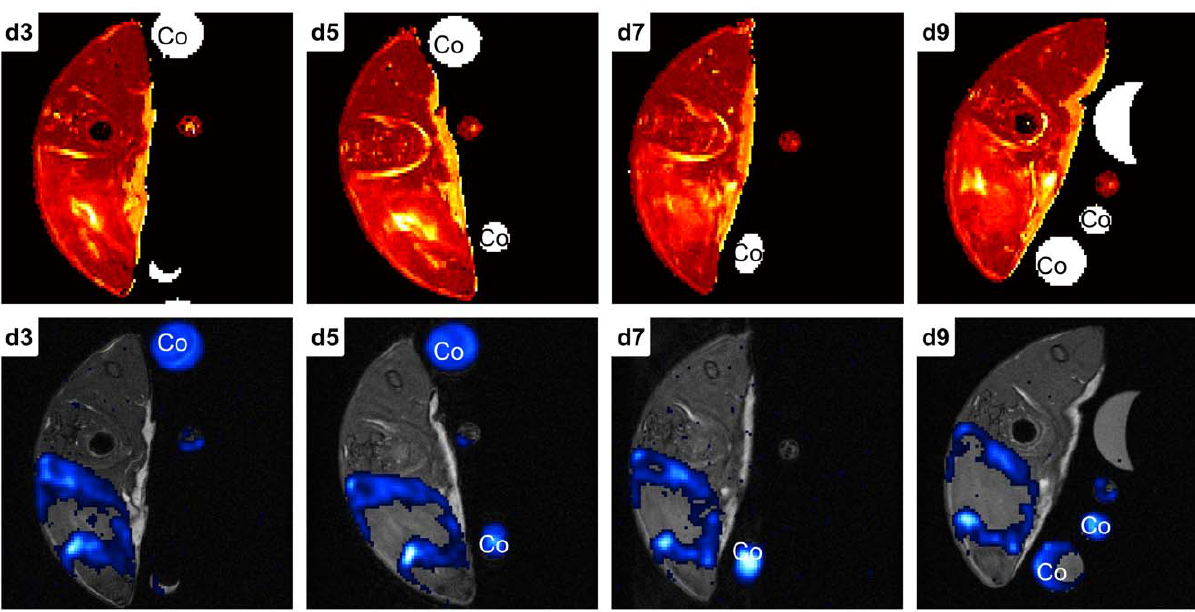
Figure 5 Representative MR-slice series showing the time course of PFC accumulation following administration at acute phase. Mouse received PFC at day 2 p.i. and was imaged every 48 h beginning at d3 p.i.. The upper row of images shows T 2 weighted MR-slices, the lower row the corresponding 19 F-SSFP CSI overlays on 1 H-TSE images. 19 F signal could be visualized in all measurements until d9 p.i. (end point).